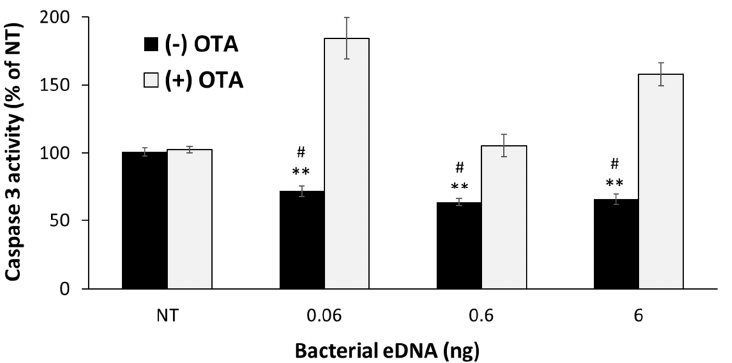
Figure 4. Caspase 3 activity in ex vivo human skin following 24 h of eDNA treatments isolated from S. aureus biofilms and subsequent irradiation with a UVB source at 300 mJ/cm 2 (black bars). The white bars show the caspase 3 activity of the co-treatments of eDNA and ochratoxin A (OTA), an Nrf2 mechanism inhibitor. The eDNA treatments significantly reduced the caspase 3 activity, while the OTA co-treatments led to significantly increased caspase 3 activity. The results were normalized to a nontreated control and presented as a percentage of NT. ** p < 0.01, treated sample vs. NT; # p < 0.001, (–)OTA vs. (+)OTA.